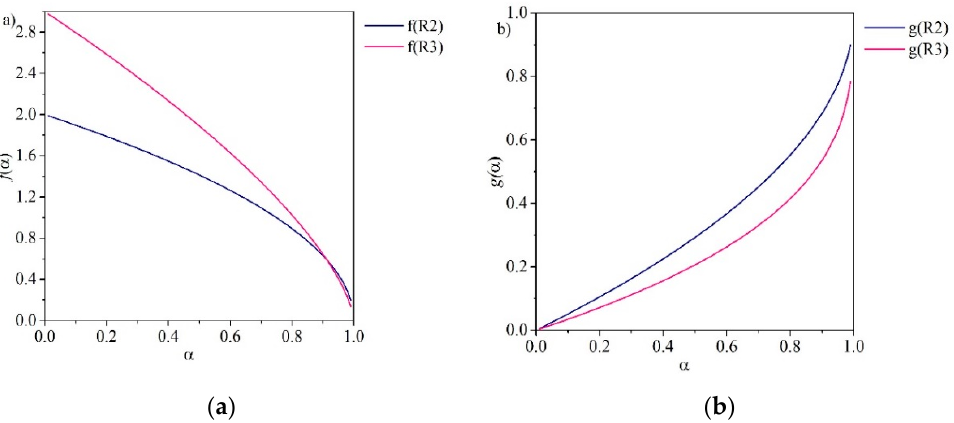
Figure 6. Geometry-based reaction models: ( a ) f ( α ) plots; ( b ) g ( α ) plots.